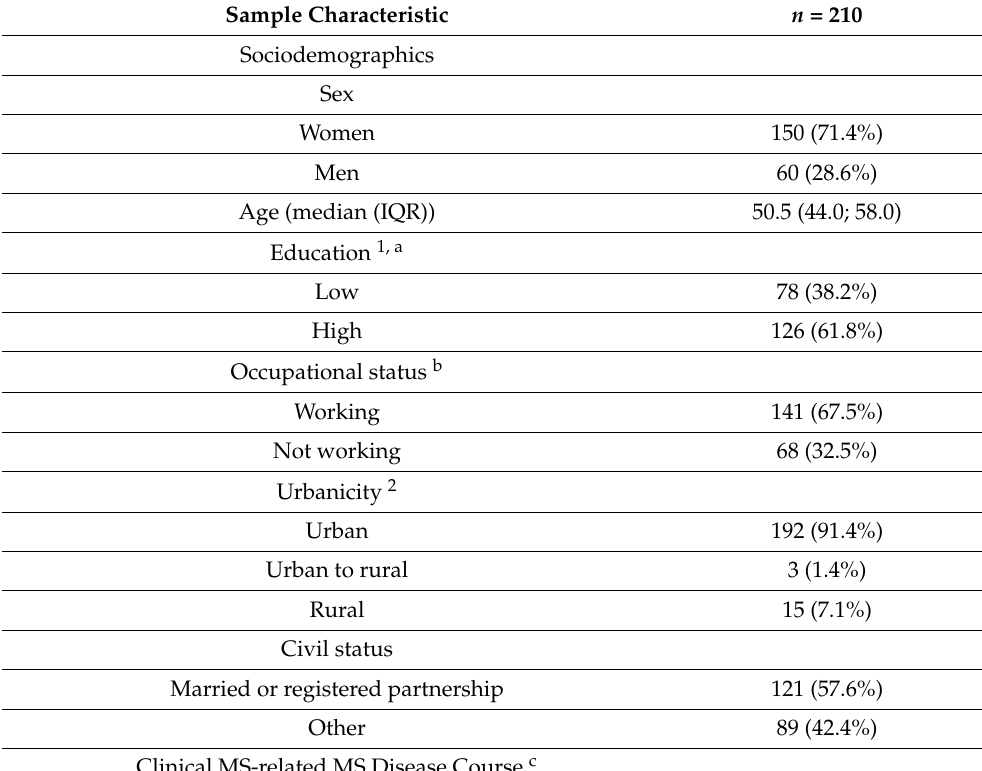
Table 1. Demographic and disease-related characteristics of the Swiss MS Registry sample ( n =